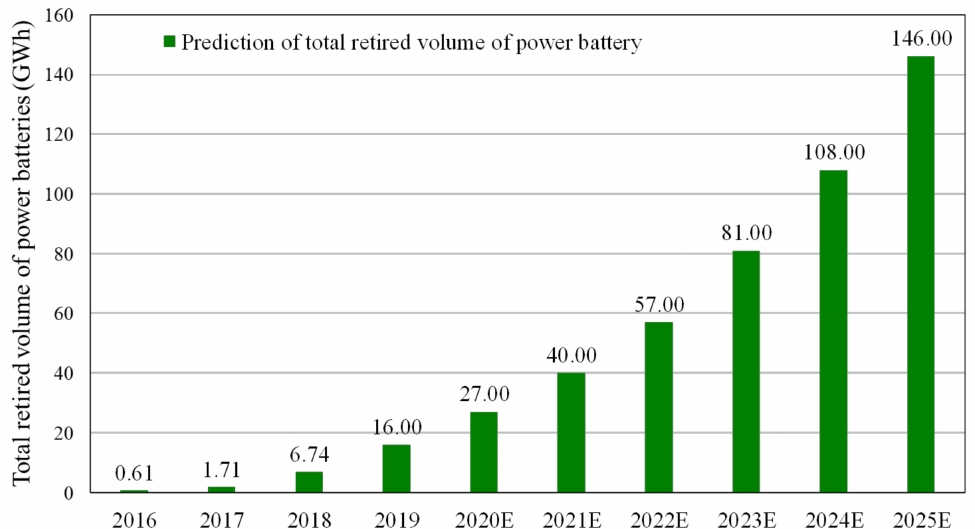
Figure 3. The total retired volume of the new energy vehicle power battery in